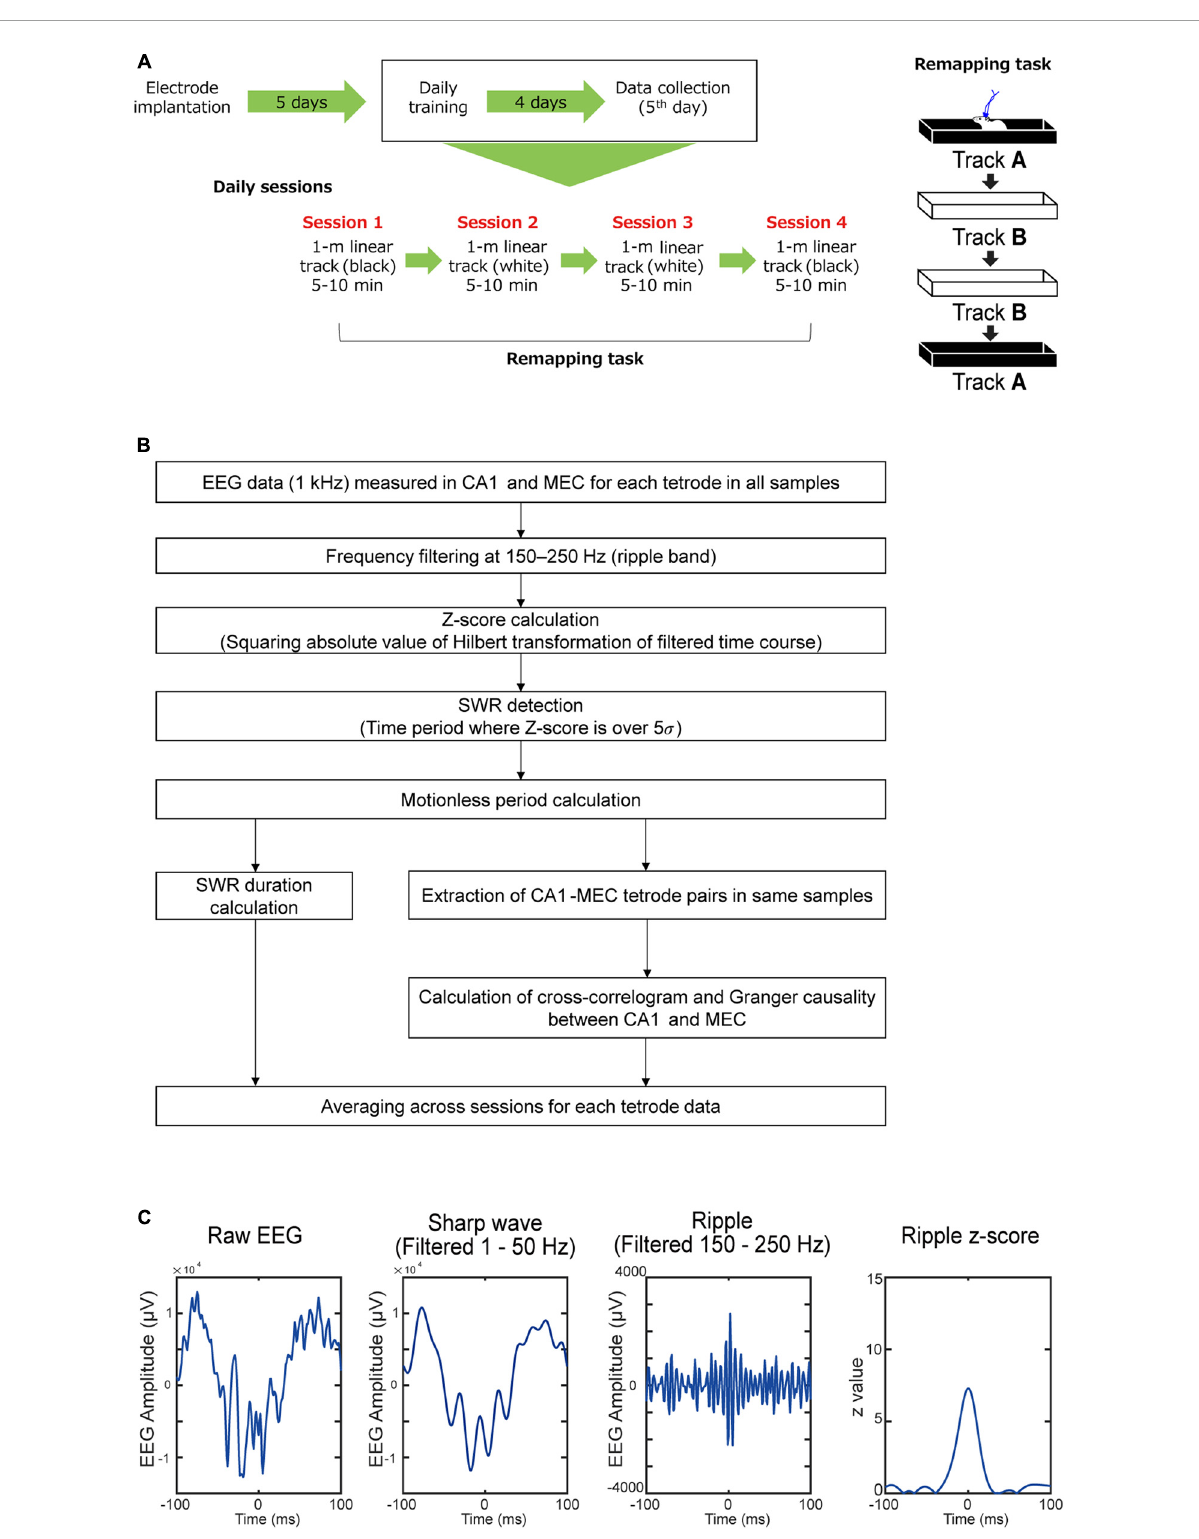
FIGURE2 Experimental procedure. (A) In vivo electrophysiological recording were performed while APP-KI mice were running linear tracks. (B) Flow of the analysis used in the study. (C) An example SWR event defined by 150–250 Hz frequency